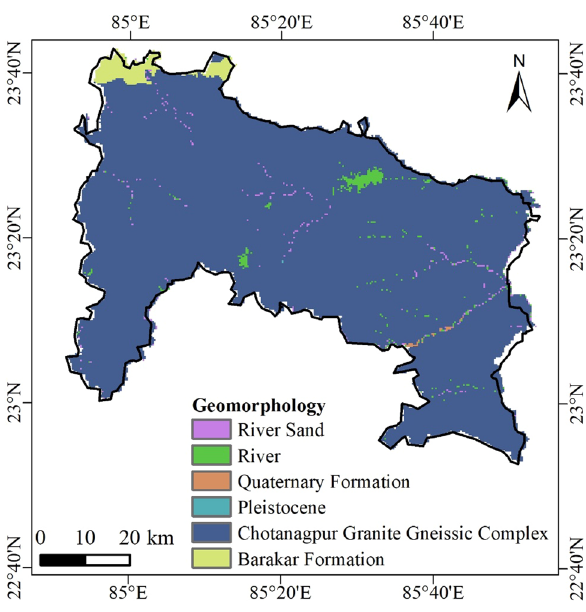
Fig. 8 Lithology map